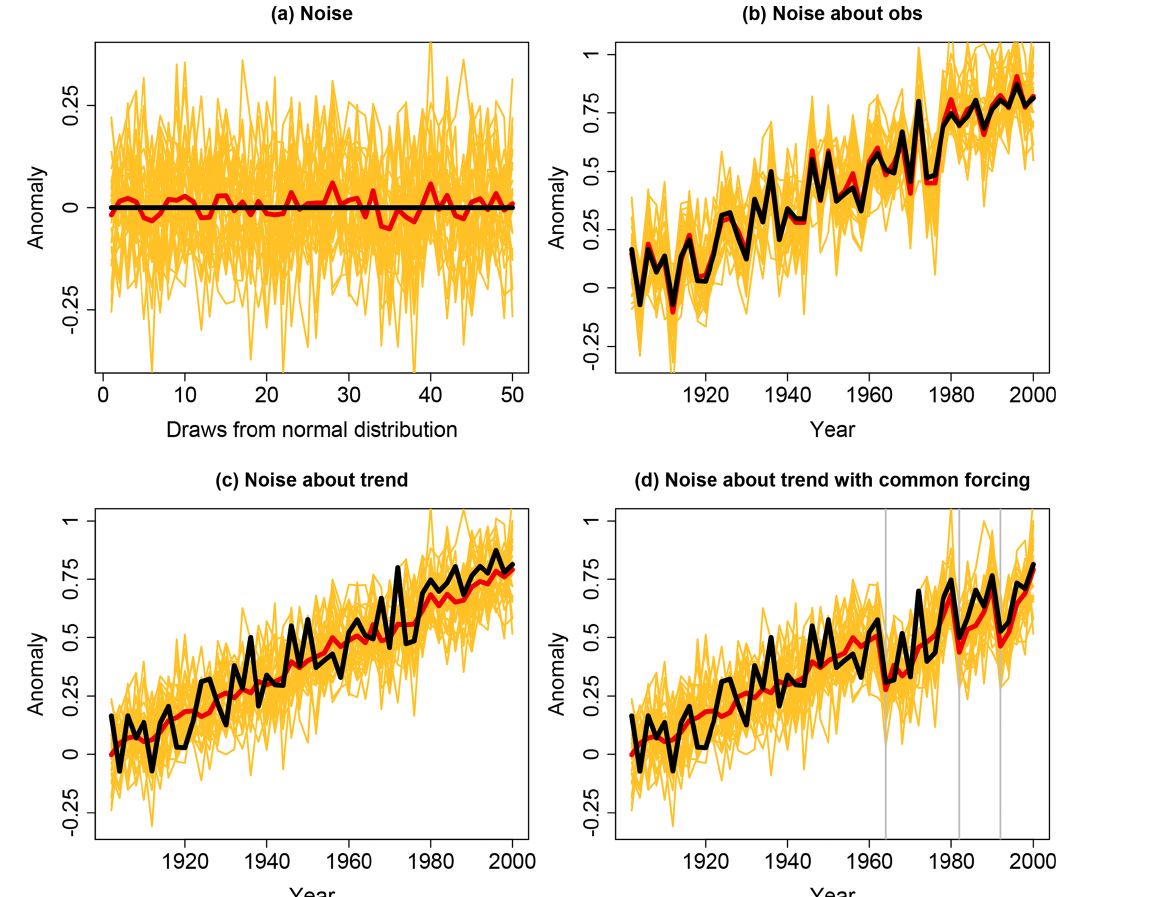
Figure 2. (a) The “truth-plus-error” paradigm illustrated using random samples from N (0,0.125) (yellow lines) as a proxy for error in models in an ensemble, with “observations” in black and the multi-model mean in red. (b) The same “models” shown as deviations from “observations” approximated by a noisy linear trend. In contrast, panel (c) illustrates model error and observation time series as draws from the same distribution, both shown as noise about a linear trend, and (d) displays the effect of applying common forcing perturbations to both models and observations. The same draws from N (0,0.125) are used in (a) – (d) .